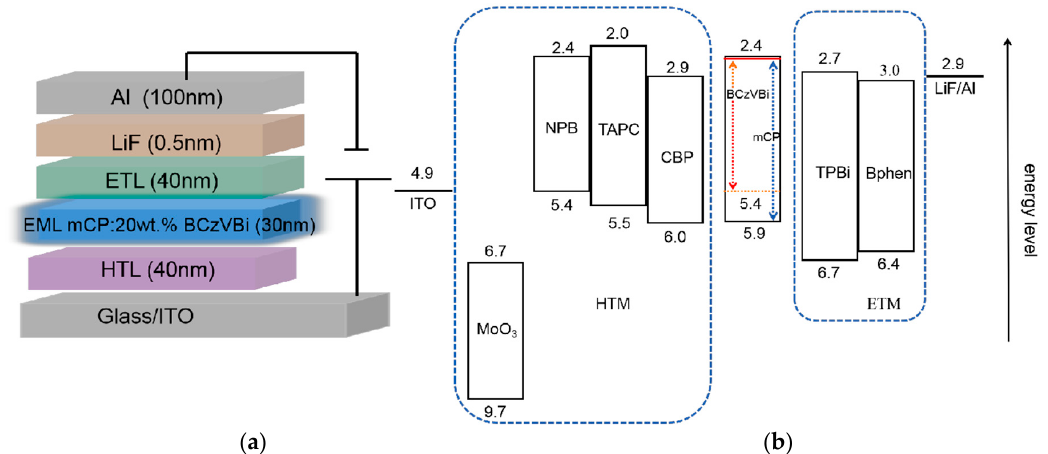
Figure 1. ( a ) The schematic structure of our blue organic light-emitting diodes (OLEDs). ( b ) The energy level diagram of the blue OLEDs.